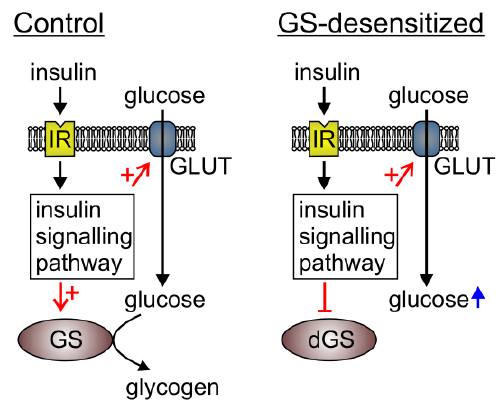
Figure 4. The mechanisms increasing the intracellular glucose level on insulin stimulation and GS desensitization in 3T3-L1 cells. In the basal state (Control), insulin stimulation does not result in increased intracellular free glucose, because glucose transport and its utilization are in equilibrium. In experiments where GS is resistant to insulin stimulation (dGS), insulin augments glucose transport, which exceeds the rate of glucose utilization. Hence, an increase in free glucose is measured. IR, insulin receptor; GLUT, glucose transporters; GS, glycogen synthase; dGS, desensitized glycogen synthase. The red arrow in combination with + indicates stimulation, red arrow with ┴ designates inhibition. Short black arrows indicate insulin signaling and long black arrows indicate glucose pathway. Blue arrow indicates increased glucose